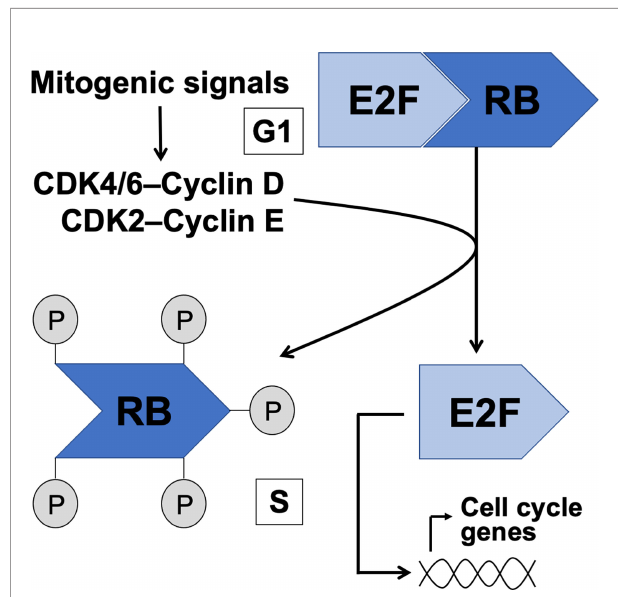
FIGURE 1 | The canonical RB-E2F pathway in control of G1 to S phase transition. Intra- and extracellular mitogenic signals are considered to converge on CDK/cyclin activation resulting in phosphorylation of RB, release of E2F and transcription of S phase